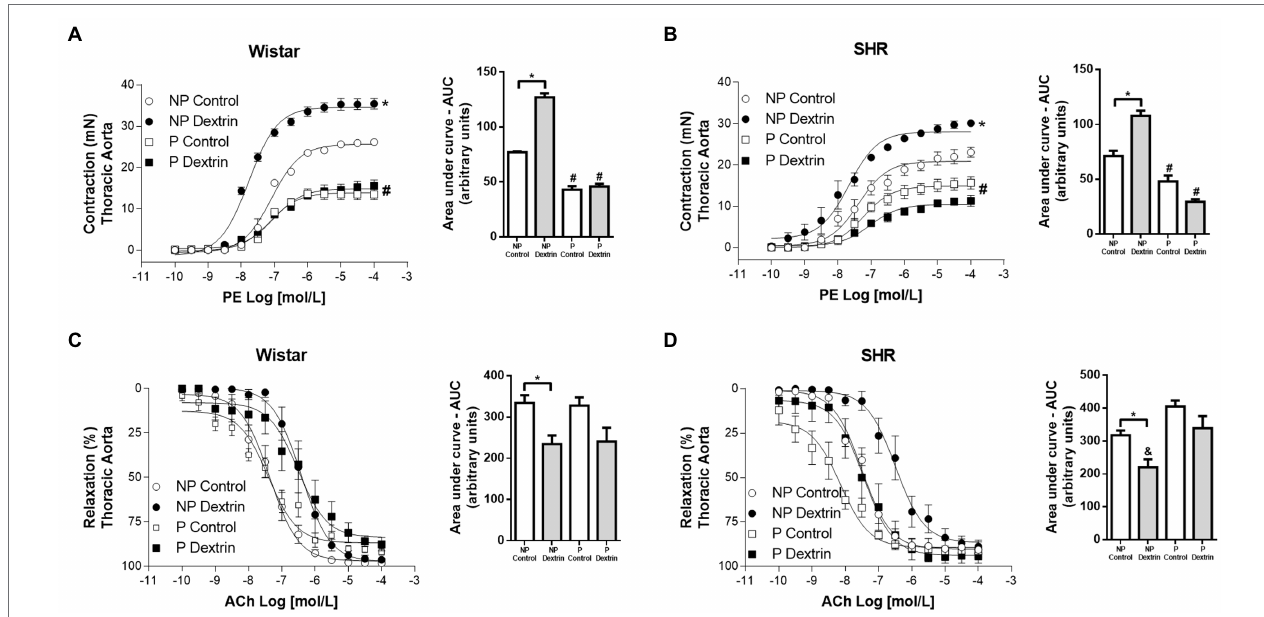
FIGURE 2 | Concentration-effect curves (0.1 nmol/L to 100 μ mol/L) to phenylephrine (PE, in A,C ) and acetylcholine (ACh, in B,D ) in aortic rings from non-pregnant (NP) and pregnant (P) Wistar and spontaneously hypertensive (SHR) rats in the presence of vehicle or dextrin (10 mmol/l). From the concentration-effect curves, we calculated the area under the curve (AUC). The data represent the mean ± SEM of the results ( n = 5). * p < 0.05 E max /AUC NP dextrin versus NP control; # p < 0.05 E max /AUC P control and P dextrin versus NP control and NP dextrin; & AUC NP dextrin versus P control and P